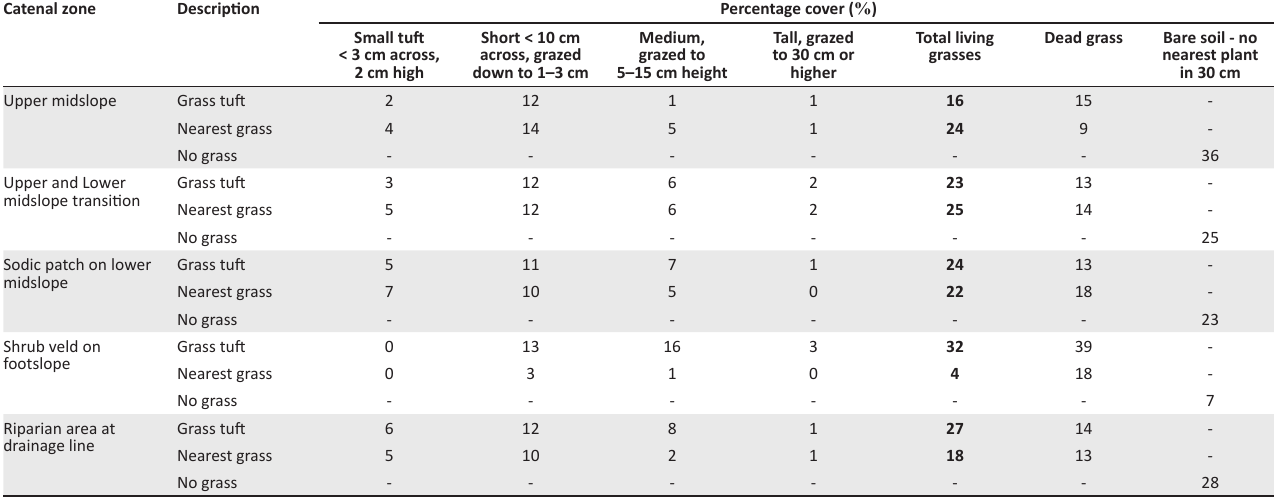
TABLE 2: Percentage of grass tufts of a certain size touched by the metal rod (hit) of the point method (100 points per line) at the end of the growing season of 2016, during the drought. The percentage of dead grass and bare soil (no hit) was also included. Catenal